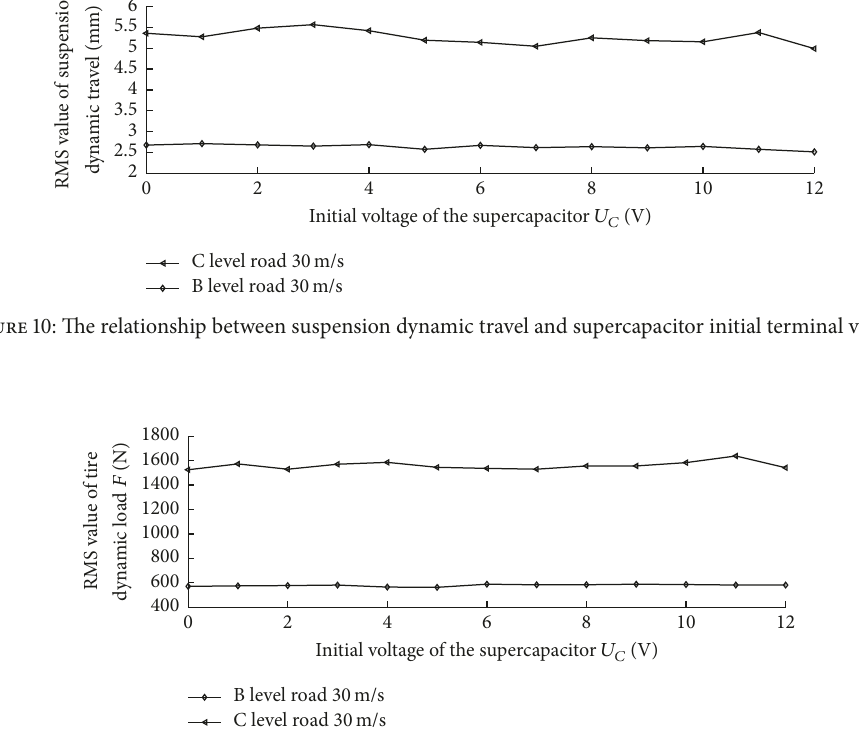
Figure 11: The relationship between tire dynamic load and supercapacitor initial terminal